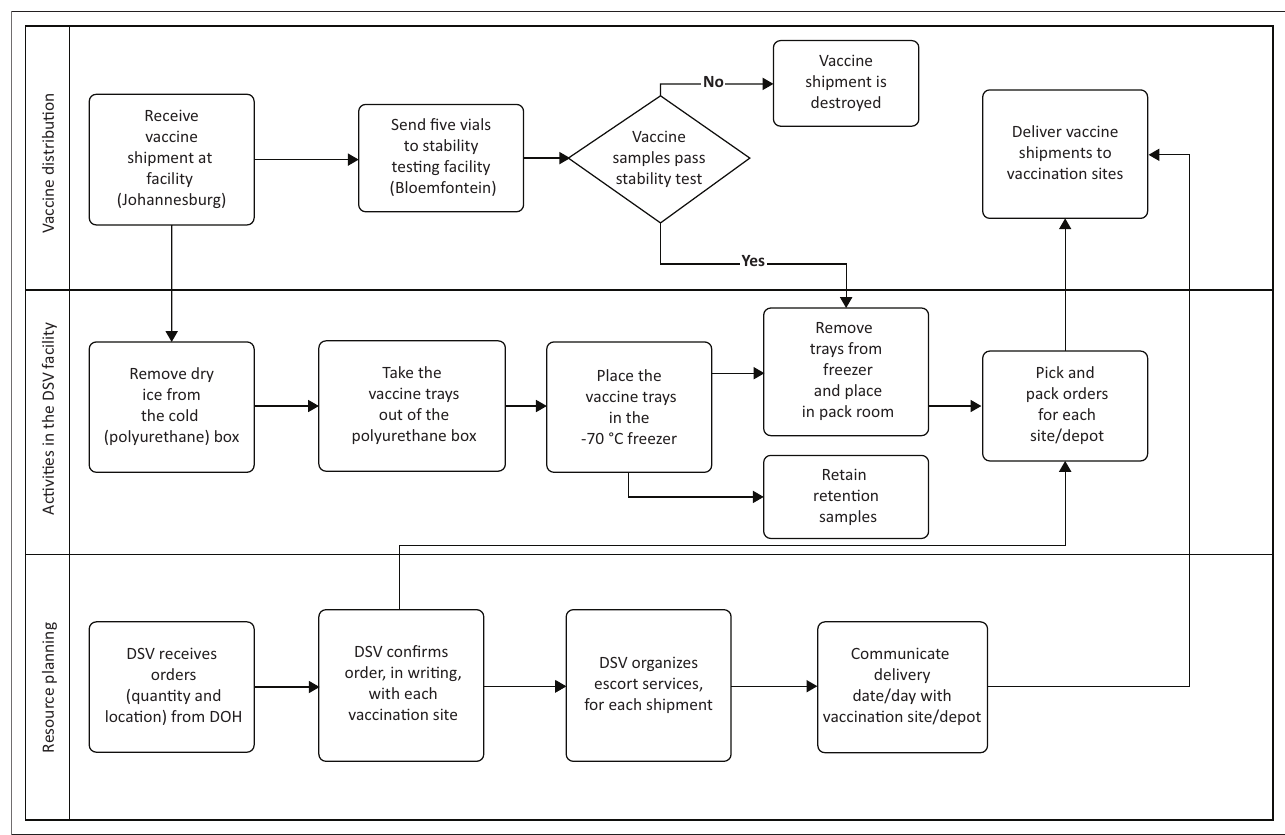
FIGURE 2: Central storage facility COVID-19 vaccine